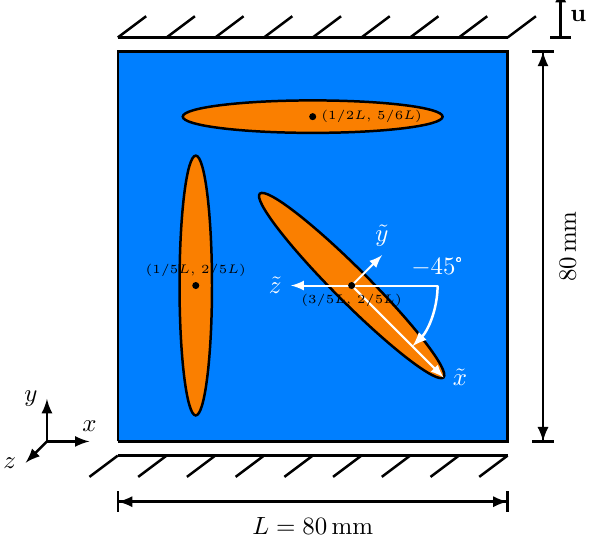
Figure 9. Simulation domain with three differently oriented elliptic, transversely isotropic, brittle inclusions in a ductile matrix, accompanied by the applied mechanical boundary conditions. The anisotropic brittle phases are represented in orange, while the ductile matrix is represented in